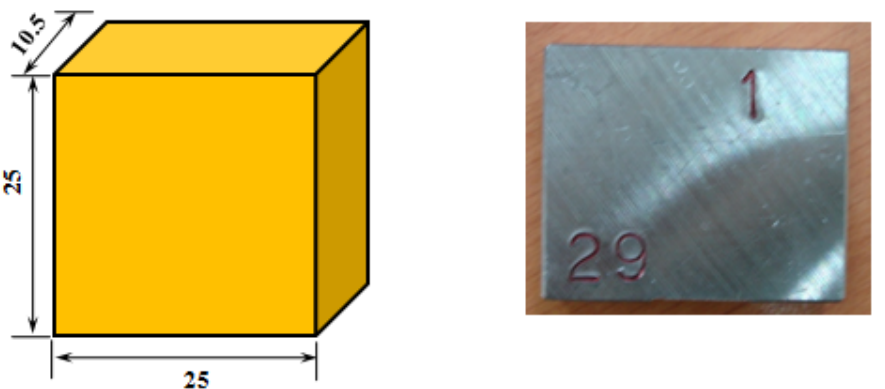
Figure 1. EN-30B alloy steel workpiece sample for experiment 1 and 29 (all dimensions are in mm).